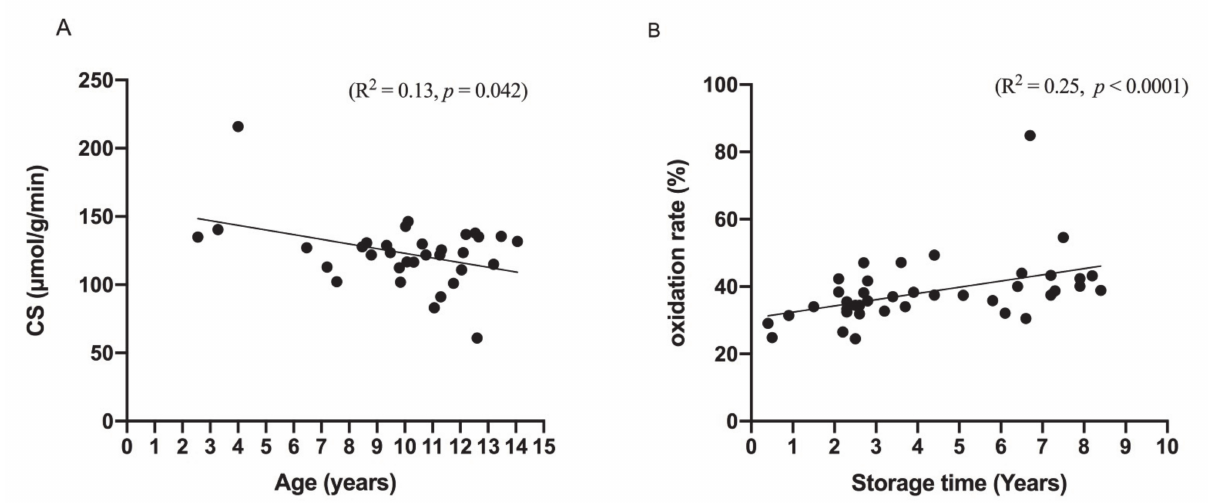
Figure 2. Significant associations between ( A ) myocardial citrate synthase (CS) activity and age of the dogs ( n = 34) and ( B ) between oxidation rate and storage time of the tissue from tissue sampling to analysis of Q10 concentrations. p - and R 2 values are from simple linear regression